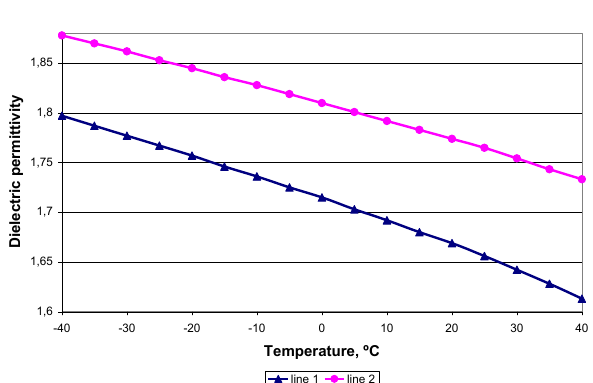
Fig. 5. Temperature dependence of dielectric permittivity for propane (line 1) and butane (line 2). Diagrams for temperature dependencies of dielectric permittivity for propane (line 1) and butane (line 2) are shown in Fig. 5. Modeling results for temperature error of LPG mass measurement in measuring system with RF sensor tuned for propane mass measurement are in Fig. 6: line 1 – error of propane mass measurement without temperature correction; line 2 – error of butane mass measurement without temperature correction; line 3 – error of propane mass measurement with temperature correction + 0,06 % per 1 ºС ; line 4 – error of temperature for propane).